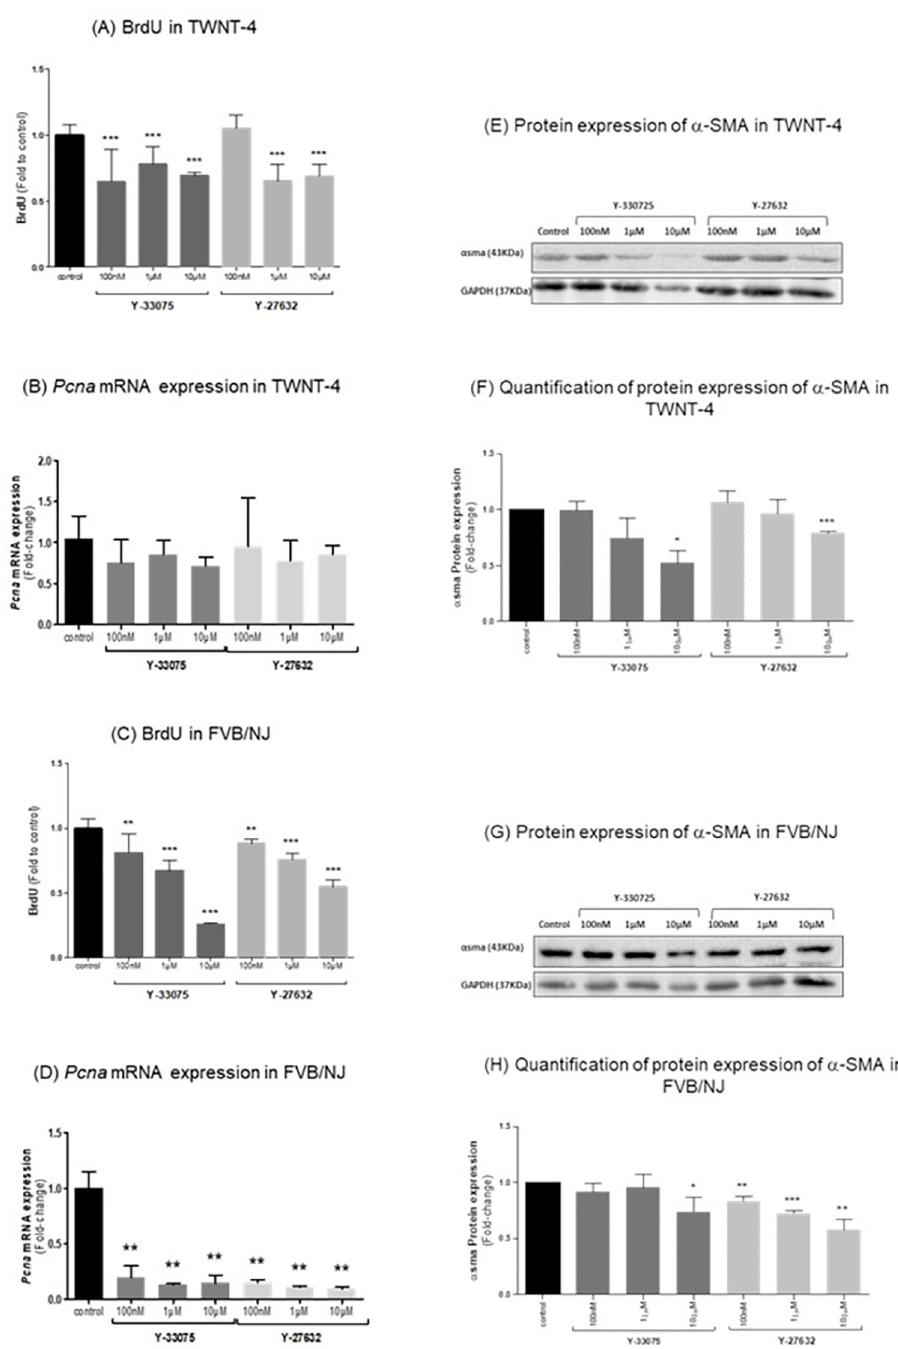
Fig 4. Y-27632 and Y-33075 treatments decrease proliferation in human TWNT-4 and primary mouse HSCs. (A) Colorimetric BrdU evaluation of proliferation levels in TWNT-4 cells after 24h treatment with ROCK inhibitors (n = 3). (B) mRNA expression of Pcna as a marker for proliferation in TWNT-4 cells (corrected against 18s as a housekeeping gene) after 24 hour treatment with ROCK inhibitors. (C) Effect of 24 hour ROCK inhibitor treatments on proliferation in murine FVB/NJ cells assessed by colorimetric BrdU-Assay (n = 3). (D) mRNA expression of Pcna as a marker for proliferation in FVB/NJ cell lysates (corrected against 18s as a housekeeping gene) after 24 hour treatment with ROCK inhibitors (n = 3). (E) Protein expression of α -SMA as a marker for the activation of HSCs using cell lysates of human TWNT-4 cells after 24 hour treatment with Y-27632 and Y-33075. (F) Quantification of α -SMA protein expression after treatment of TWNT-4 cells with ROCK inhibitors for 24 hours (n = 3). (G) α -SMA